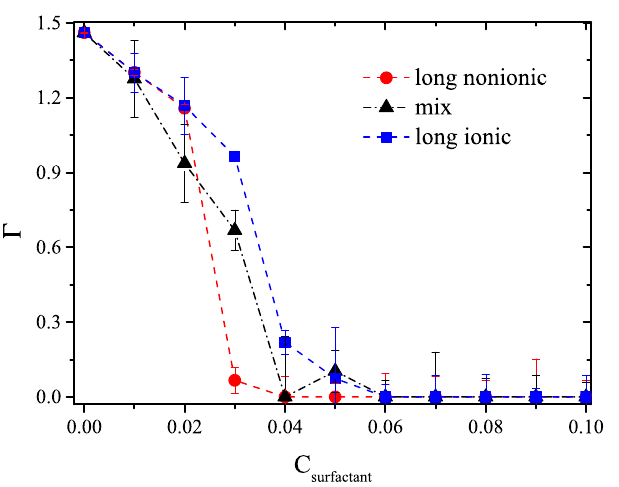
Figure 9. Desorption isotherms (Г) of heptane using a 50:50 mixture of nonionic and ionic surfactants. The red circles (nonionic surfactants) and blue squares (ionic surfactants) are the same isotherms presented in Fig. 5A and B, respectively, for long surfactants and are included here to emphasize the effect of the surfactant mixture. The black triangles correspond to a 50:50 mixture of ionic and non-ionic